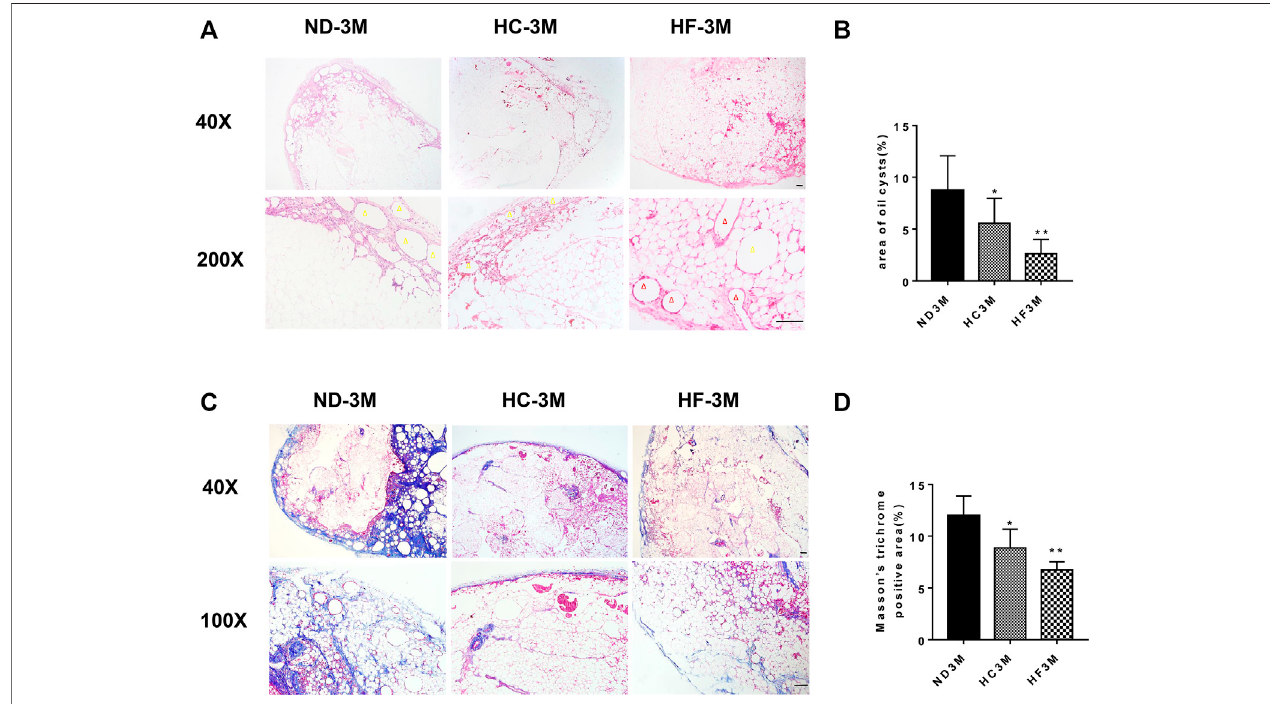
FIGURE 3 | Histological changes in fat grafts. Representative HE staining of grafts obtained on day 90 (A) , and the quanti fi cation of the area of oil cysts (B) . RepresentativeMassontrichromestaining (C) and thequanti fi cationofMasson trichrome staining (D) of90-daysfatgrafts from miceon differentdiets.Graftson day90 are marked as ND-3M, HC-3M, and HF-3M. Yellow arrow: oil cyst. Red arrow: microvessel. Scale bars = 100 μ m ** p < 0.01 and * p <